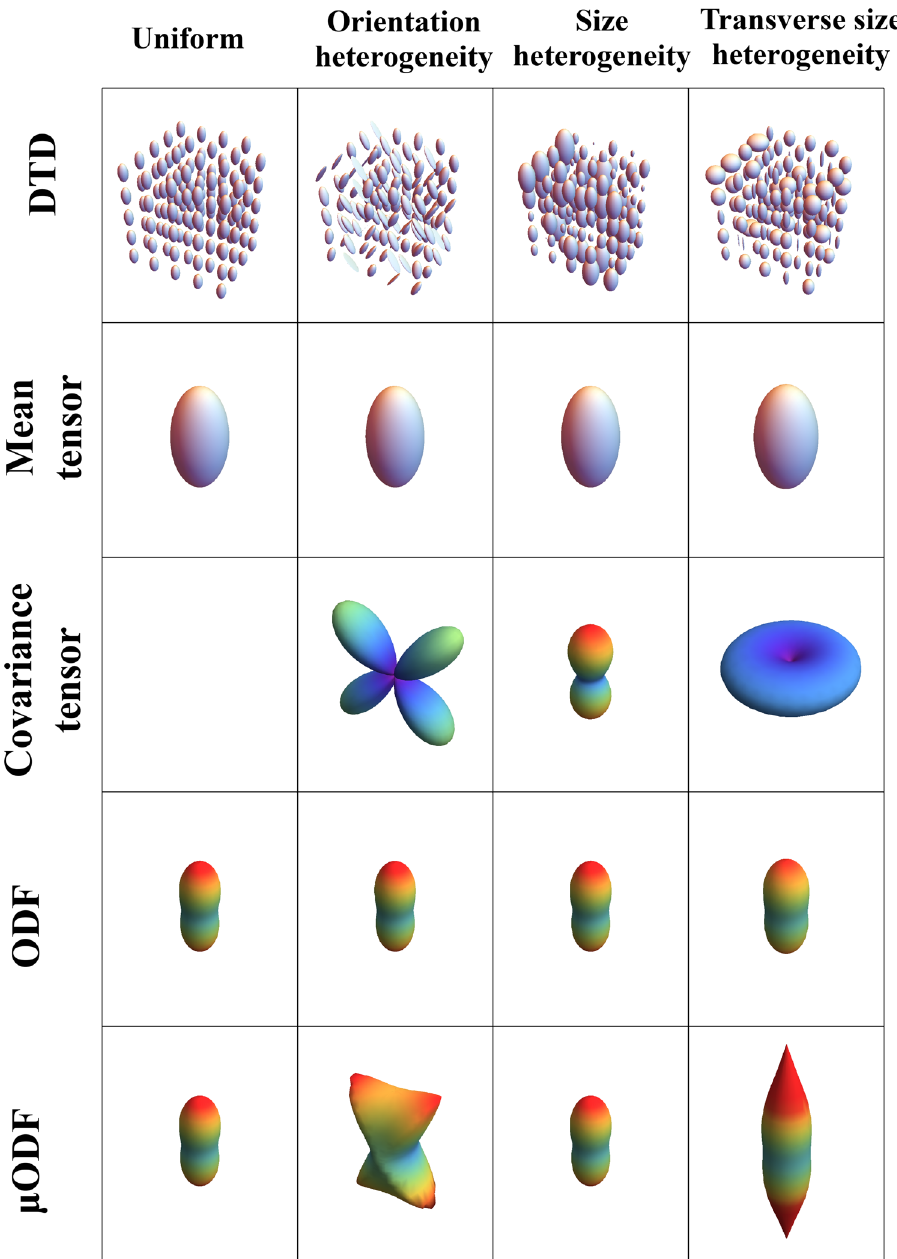
Figure 8. Glyphs describing macroscopically anisotropic and microscopically heterogeneous DTDs generated from CNTVD. (First row) DTDs describing uniform, orientation, size, and transverse size heterogeneous voxels respectively. (Second row) Second order mean tensor displayed as an iso-surface for each of the DTDs. (Third row) Fourth order covariance tensor projected in 3D for each of the DTDs. (Fourth row) Macro ODF obtained from the mean diffusion tensor. (Fifth row) Micro ODF obtained by averaging the ODFs of individual micro diffusion tensors in the voxel. The above graphics was generated using the Mathematica software 67